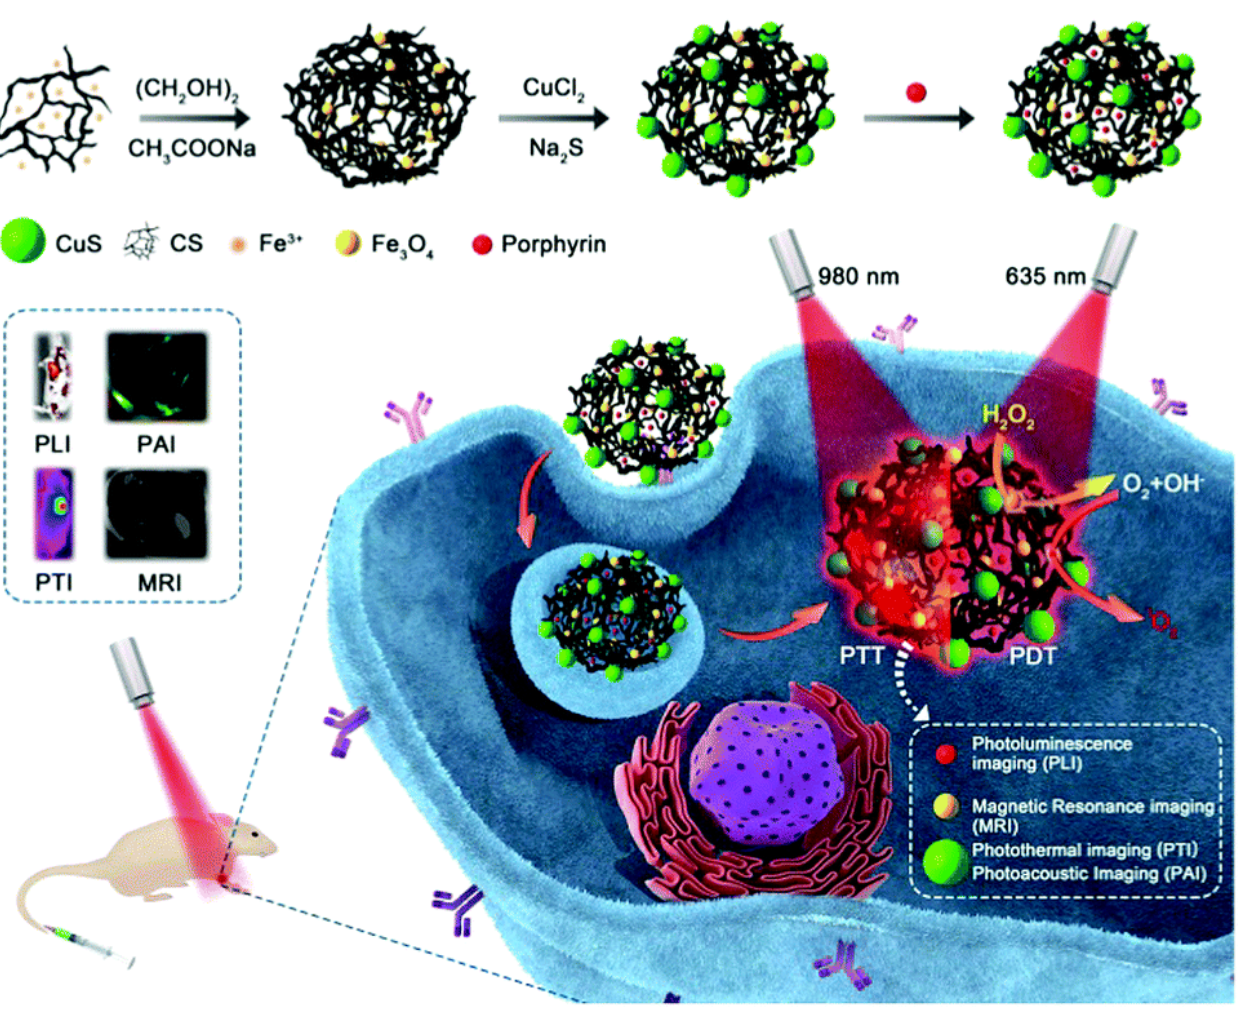
Figure 4. Peroxidaselike Fe 3 O 4 nanocomposite (FCCP) nanoplatform for photo-induced cancer theranostics. Reproduced with permission from [63].